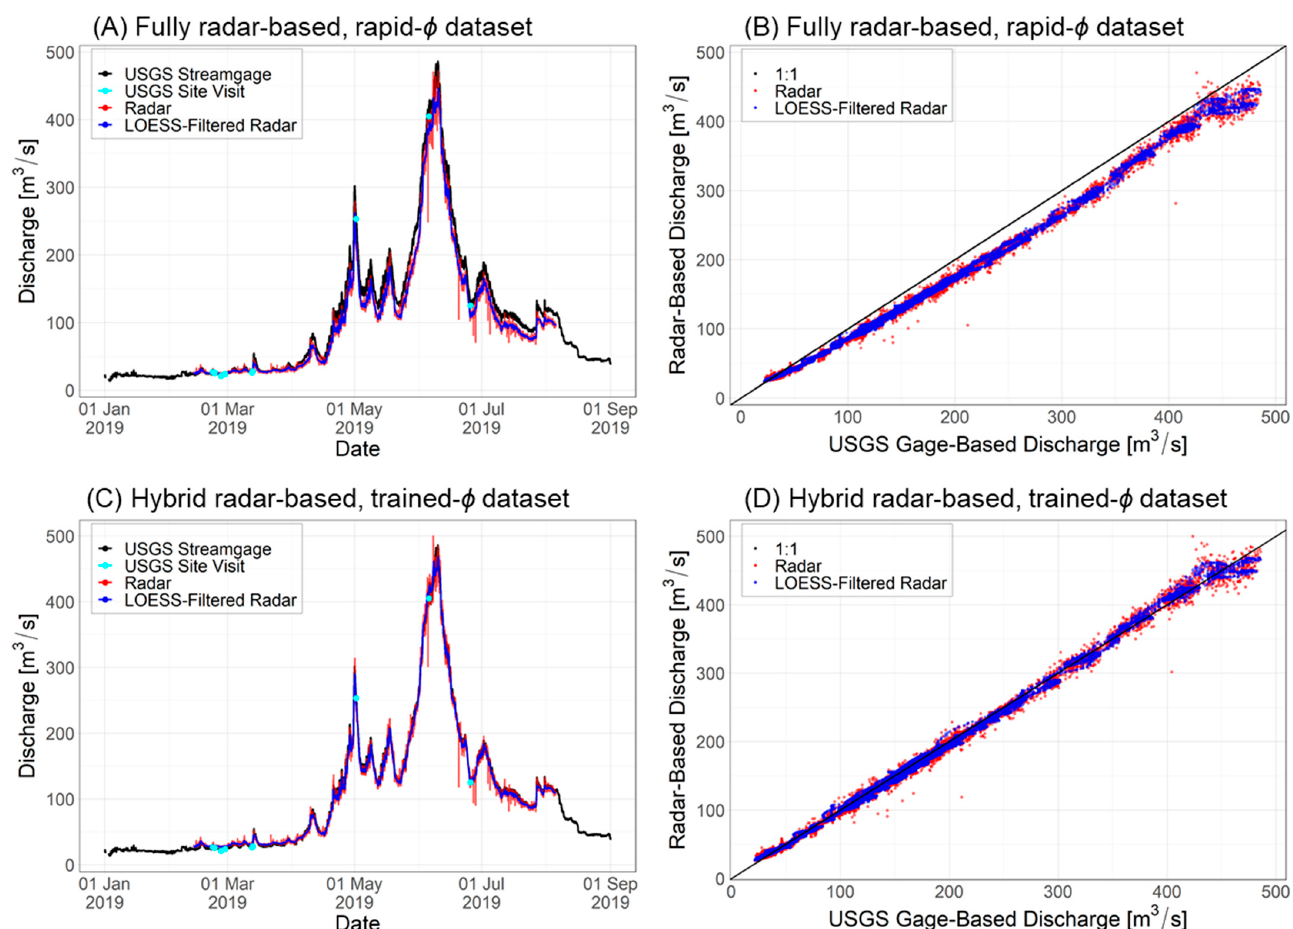
Figure 5. Comparisons of unfiltered (raw) radar-based discharge estimates (red), LOESS-filtered radar-based discharge estimates (royal blue), continuous USGS-streamgage-based discharge estimates (black), and USGS site visit stage discharge measurements (cyan), for the fully radar-based, rapid- ϕ dataset ( A , B ) and the hybrid-radar-based, trained- ϕ dataset ( C , D ). These include the time series of both datasets ( A , C ) and scatterplots of both radar-based discharge datasets versus USGS continuous streamgage-based datasets ( B , D ).